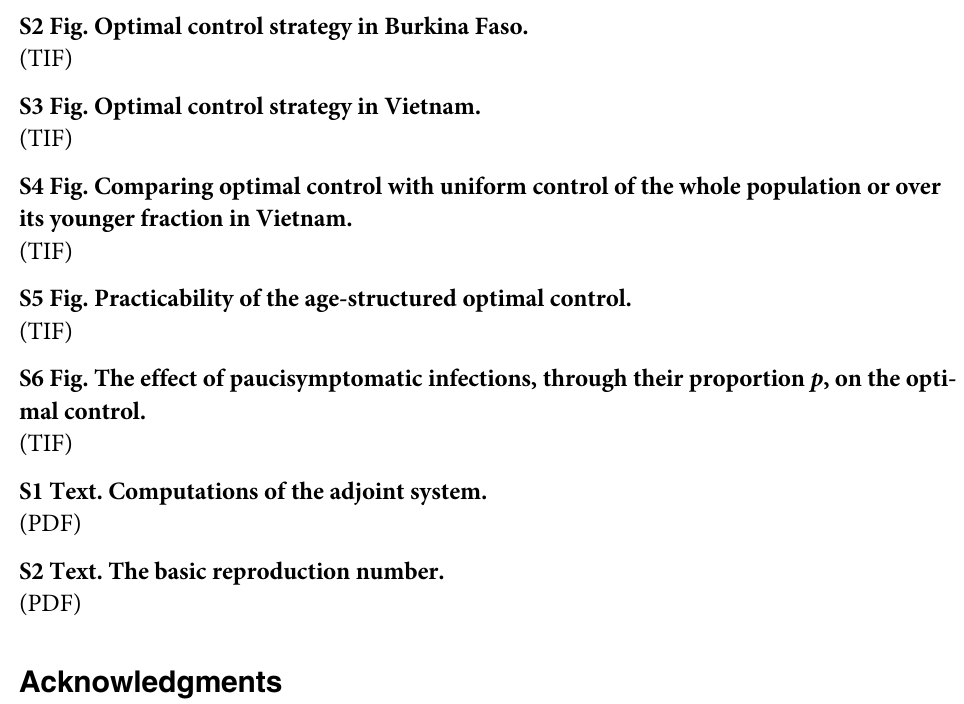
S1 Fig. Global sensitivity analysis.